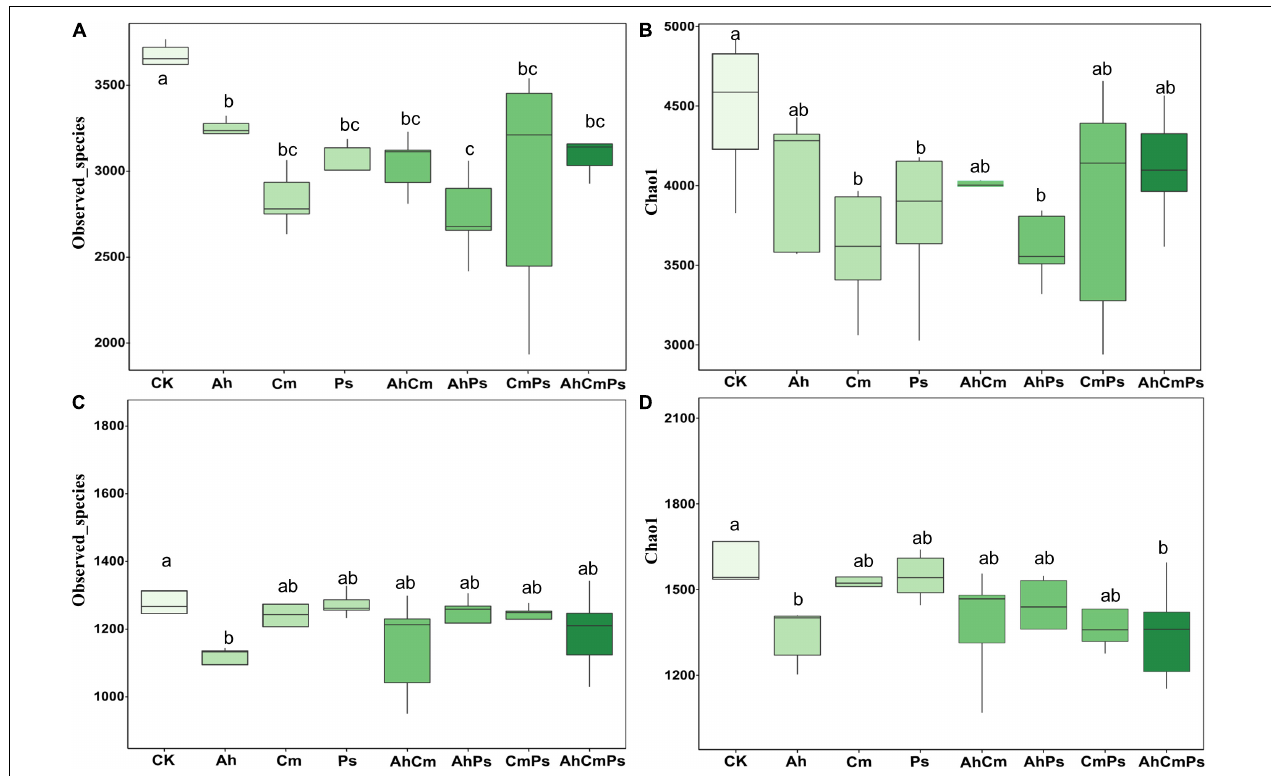
FIGURE 4 | The effects of litter addition on soil bacterial and plant diversity. (A) Bacterial Observed_species, (B) bacterial Chao 1 diversity index, (C) fungal Observed_species, and (D) fungal Chao 1 diversity index. All data are presented as the mean ± SE ( n = 5). Box plots show midline, median; box edges, first quartile and third quartile; and whiskers, minimum and maximum. The different letters indicate the significant differences between litter addition treatments ( p < 0.05).